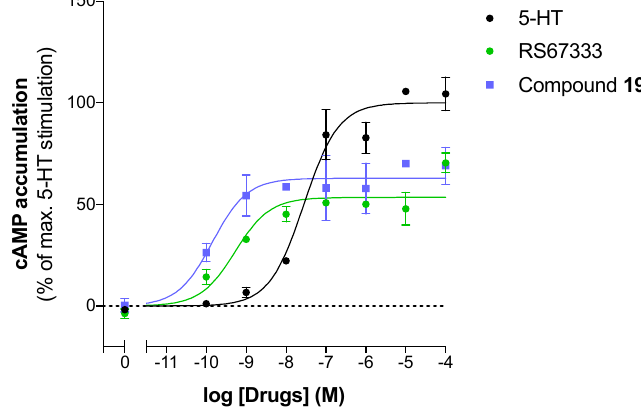
Figure 4. Pharmacological profile of RS67333 and compound 19 . Representative experiment illustrating agonist activities towards ( h )5-HT 4(a) receptors.